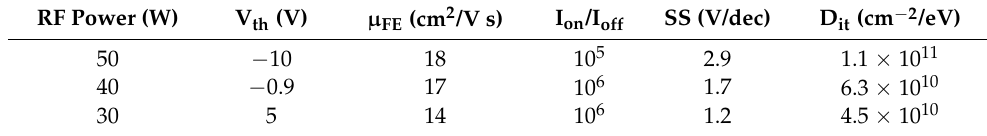
Table 1. Electrical parameters of a-InGaZnO TFTs prepared with different sputtering